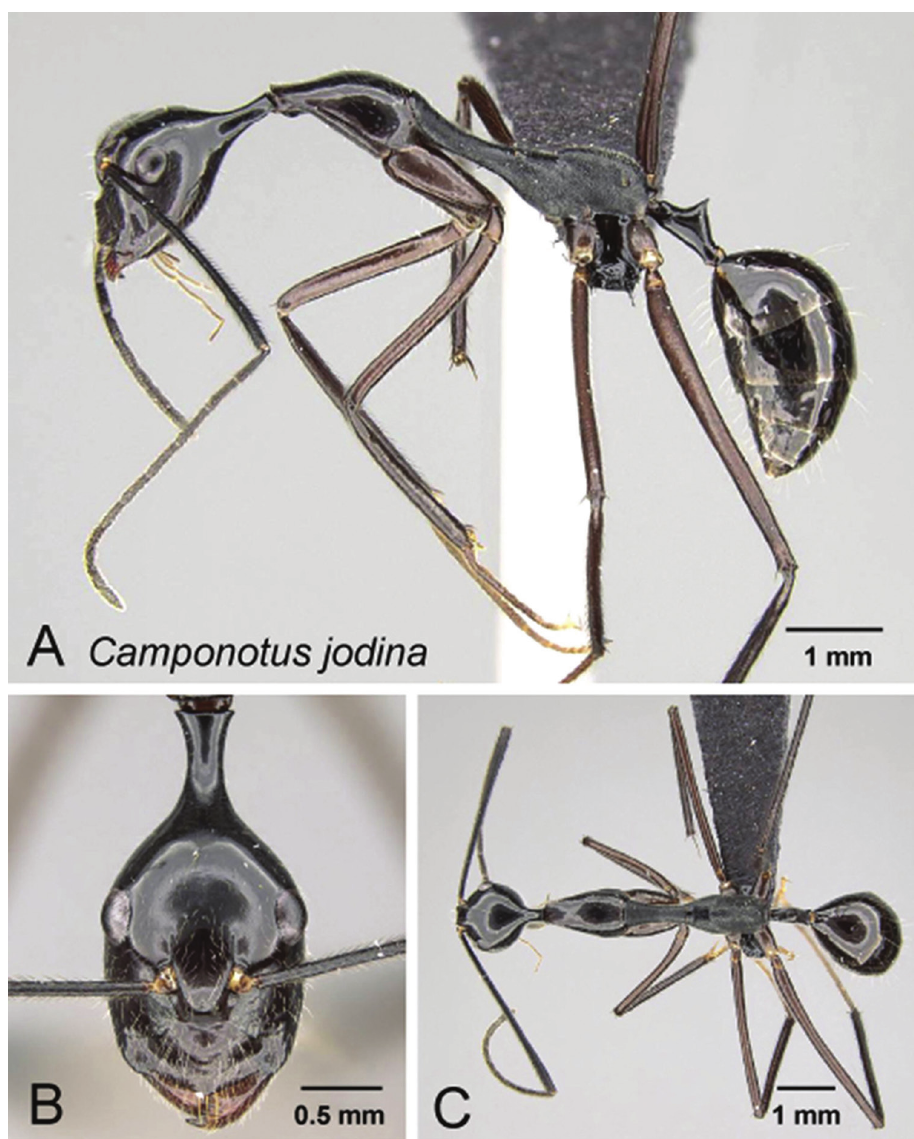
Figure 12. Camponotus jodina minor worker CASENT0152090. A Lateral view B Head in full-face view C Dorsal